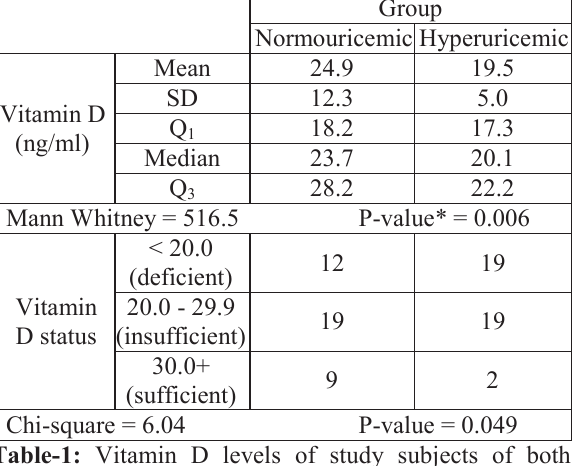
Table-1: Vitamin D levels of study subjects of both groups based on SUA level.